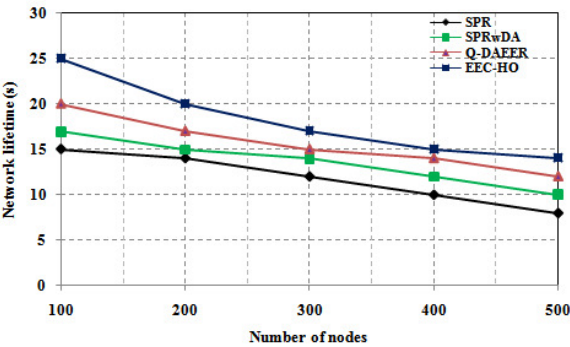
Then, we explain the process of trust computation which is used to compute optimal